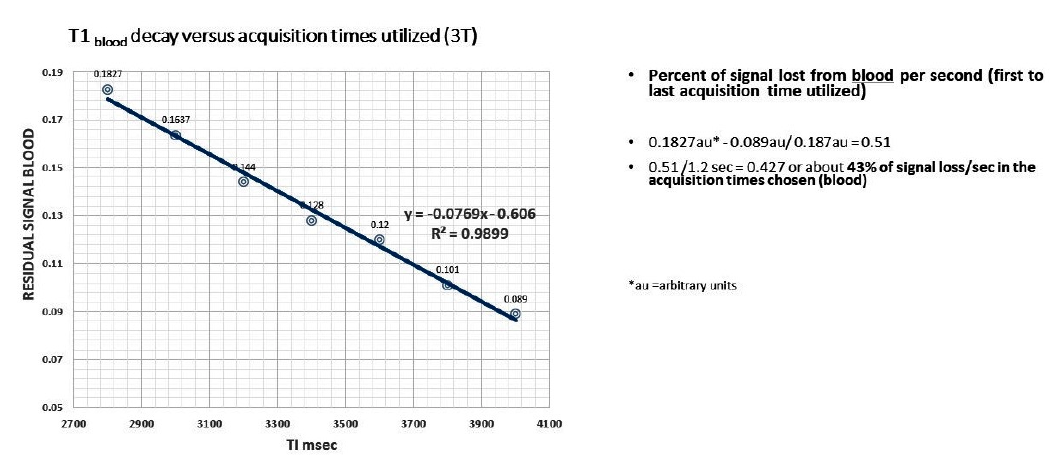
Figure A2. Linear regression of the calculated T1 CSF versus acquisition times used. Note the slope is within the range of the normal subjects and R 2 showing high correlation as plotted.